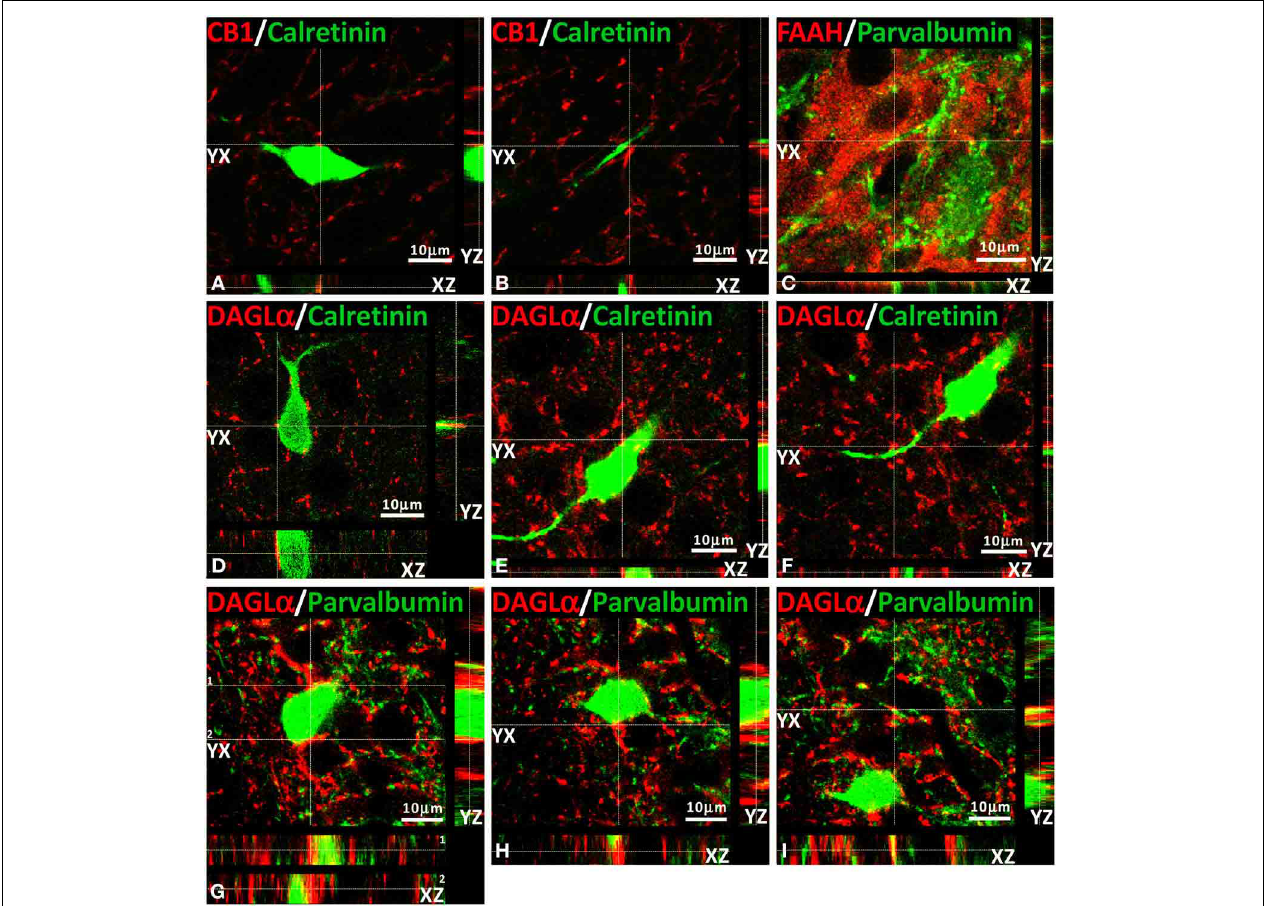
FIGURE 7 | Orthogonal sectioning views. Selected z-scanning series of images showing double immunofluorescence (red and green) of CB1, FAAH, DAGL α , calretinin, and parvalbumin. To analyze the labeling from